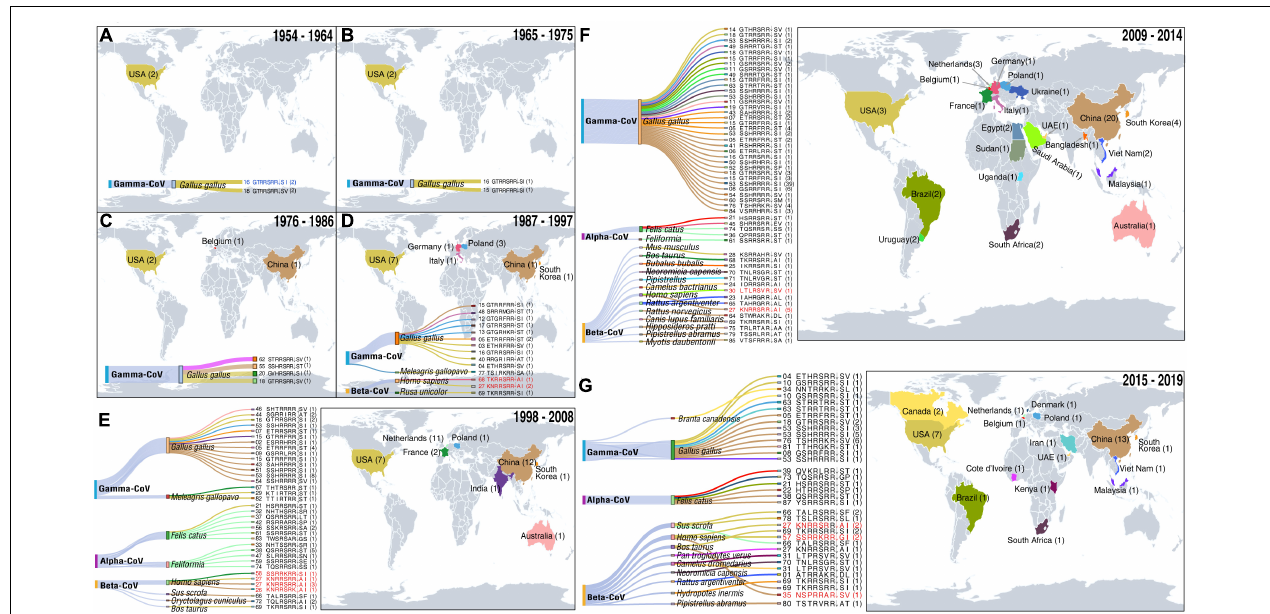
FIGURE 2 | Temporal–spatial distribution of CoVs with furin cleavage sites. For information on the sites (see Supplementary Table 1 ). (A–G) Sources of coronaviruses recorded in indicated periods with furin cleavage sites displayed in Sankey plots. Level 1 shows the virus genera, level 2 shows animal hosts of CoVs, and colors of the lines correspond to colors on the map of the countries in which the CoVs with indicated furin cleavage sites were detected. After level 2, the furin cleavage site numbers and motifs are shown. The numbers in parentheses refer to frequencies of furin cleavage motifs. Numbers on the map show numbers of types furin cleavage sites detected in the indicated countries. Furin cleavage sites from four CoVs known to infect humans (HCoV-OC43, HCoV-HKU1, MERS-CoV, and SARS-CoV) and human enteric coronavirus 4408 (HECV-4408), first detected in Germany in 1988, are marked in red. The first coronavirus with a furin cleavage site, which appeared in Gallus , is marked in blue. Records of coronaviruses with furin cleavage sites from 1954 to 2008 including five time periods (11 years per period) (A–E) , 2009–2014 (F) and 2015–2019 (G)